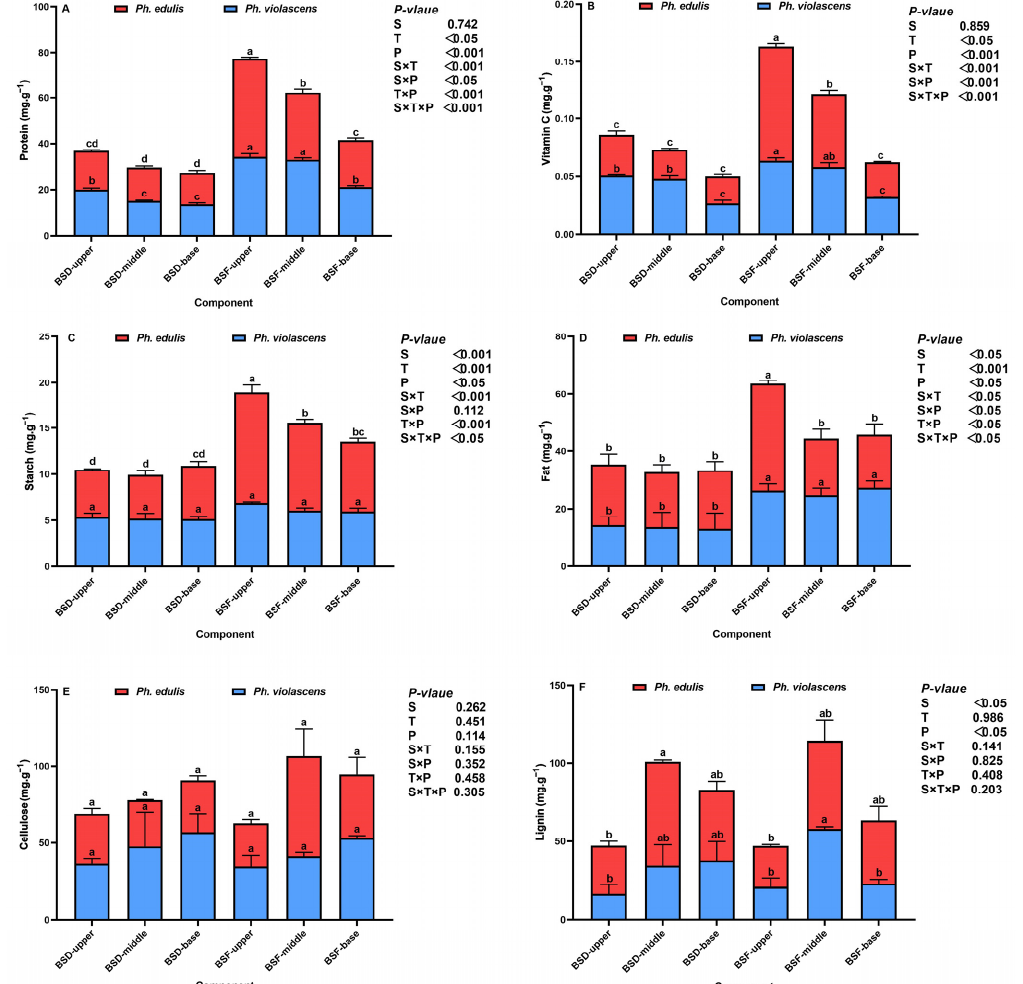
Figure 2. Changes in the nutritional status of bamboo shoot diaphragm (BSD) and flesh (BSF) between Ph. edulis and Ph. violascens . ( A ) protein, ( B ) starch, ( C ) fat, ( D ) vitamin C, ( E ) cellulose, and ( F ) lignin. BSD and BSF refer to bamboo shoot diaphragm and flesh, respectively. Vertical bars are means ± SD of the four replicates. Different lowercase letters above the bars in each graph represent significant differences ( p < 0.05) between the bamboo shoot segments. p values are only shown for the main and interactive effects of species (S), component (C), and position (P), respectively, of each